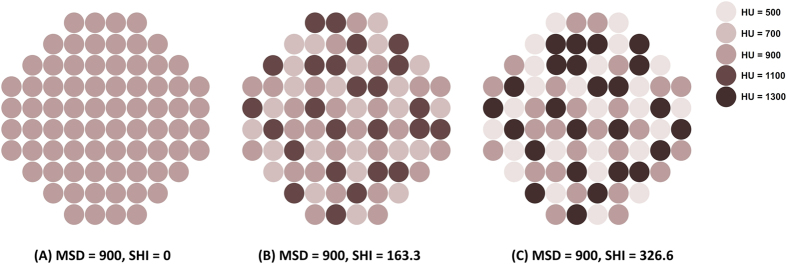
Schematic diagram showing the compositional heterogeneity of urinary calculi.All three stones demonstrate the same mean stone density (MSD) of 900 HU but their stone heterogeneity index (SHI) is different.